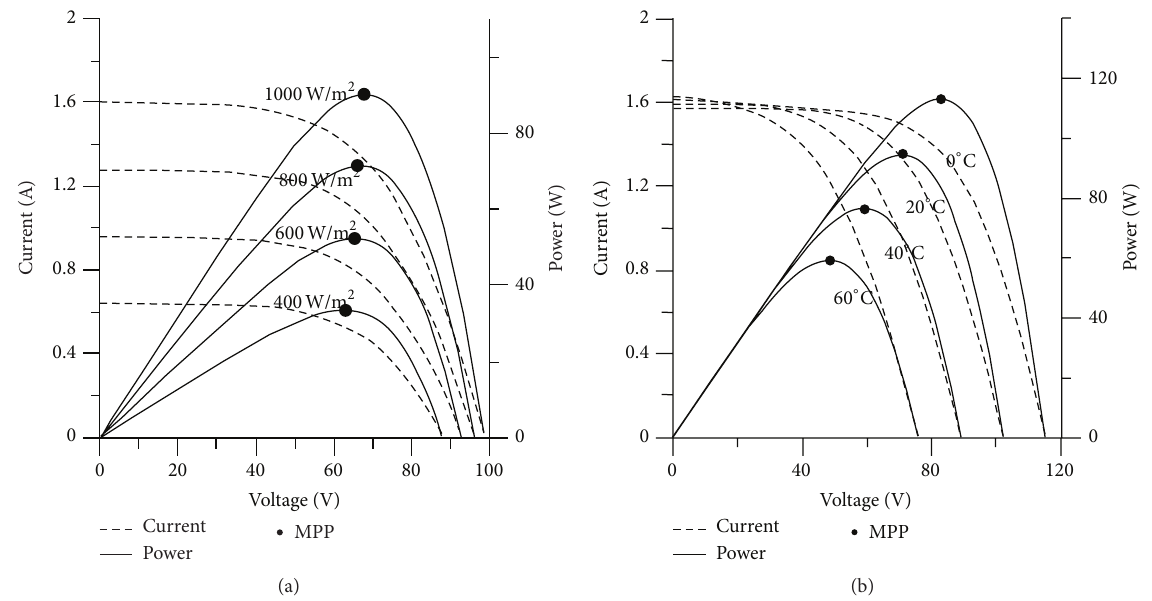
Figure 3: I-V and P-V characteristic curves for CSSS-90A under (a) different irradiation, 𝑇 = 25 ∘ C and (b) different panel temperature, irradiation at 1000W/m 2